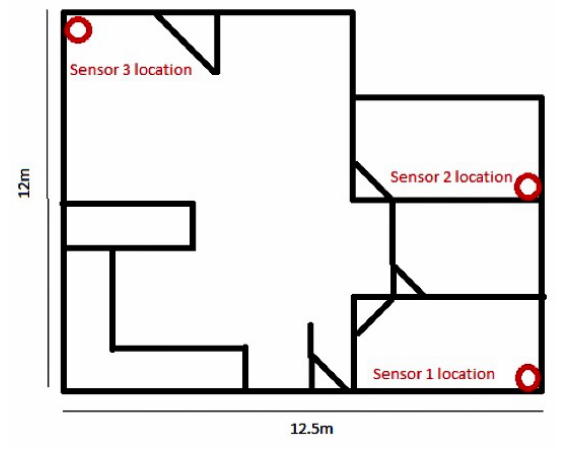
Figure 7. Cont. Figure 7. Cont